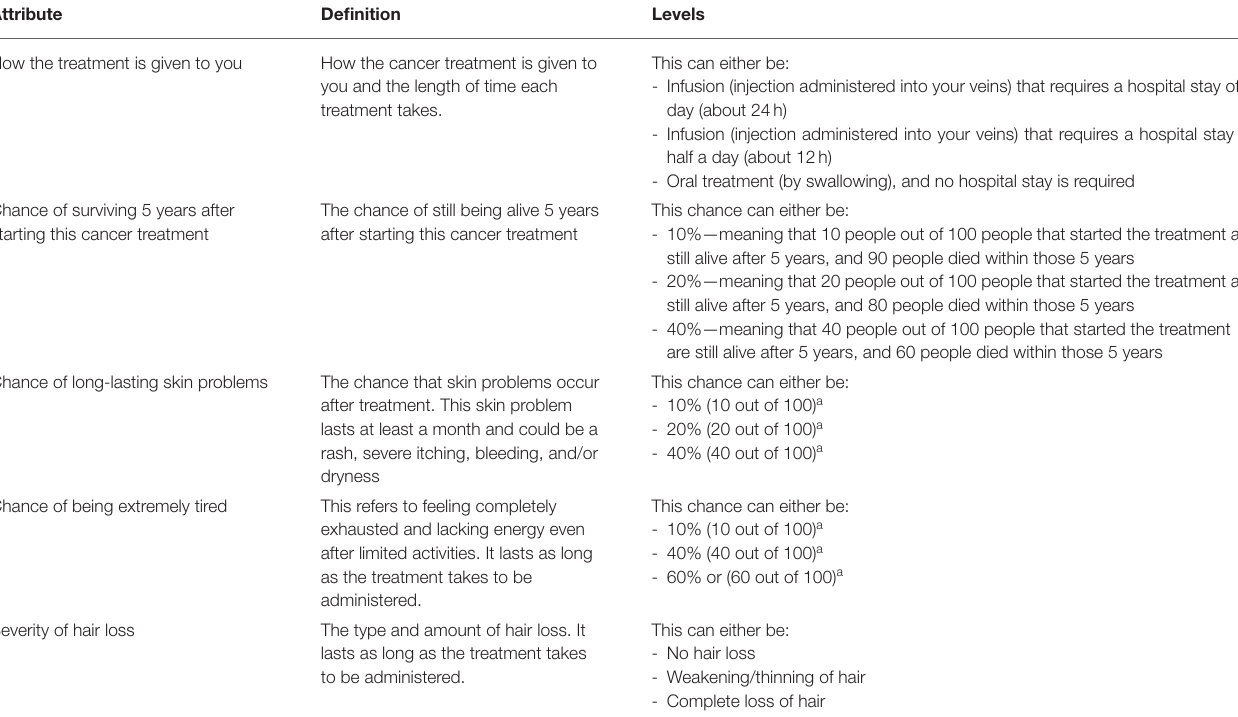
TABLE 2 | Attributes, definitions, and levels.